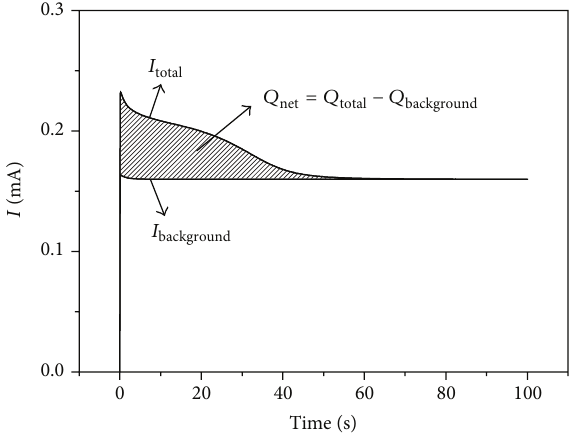
Figure 2: The response signals of the PEC